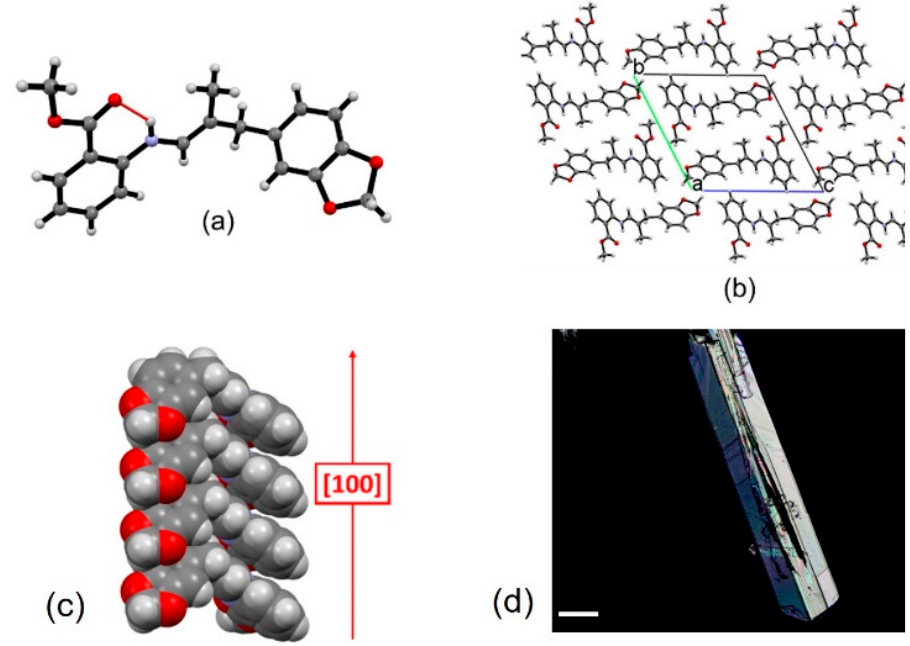
Figure 2. Structural features of crystalline SB2 : ( a ) the asymmetric unit, showing the intramolecular S 11 (6) hydrogen bonding interaction between the iminic nitrogen and carbonyl group, ( b ) crystal packing viewed down the a-axis, and ( c ) detail of the columnar stacking extending along the [100] crystallographic direction; ( d ) optical microscope image (polarized light) of the crystals of SB2 . Scalebar is 100 μ m .